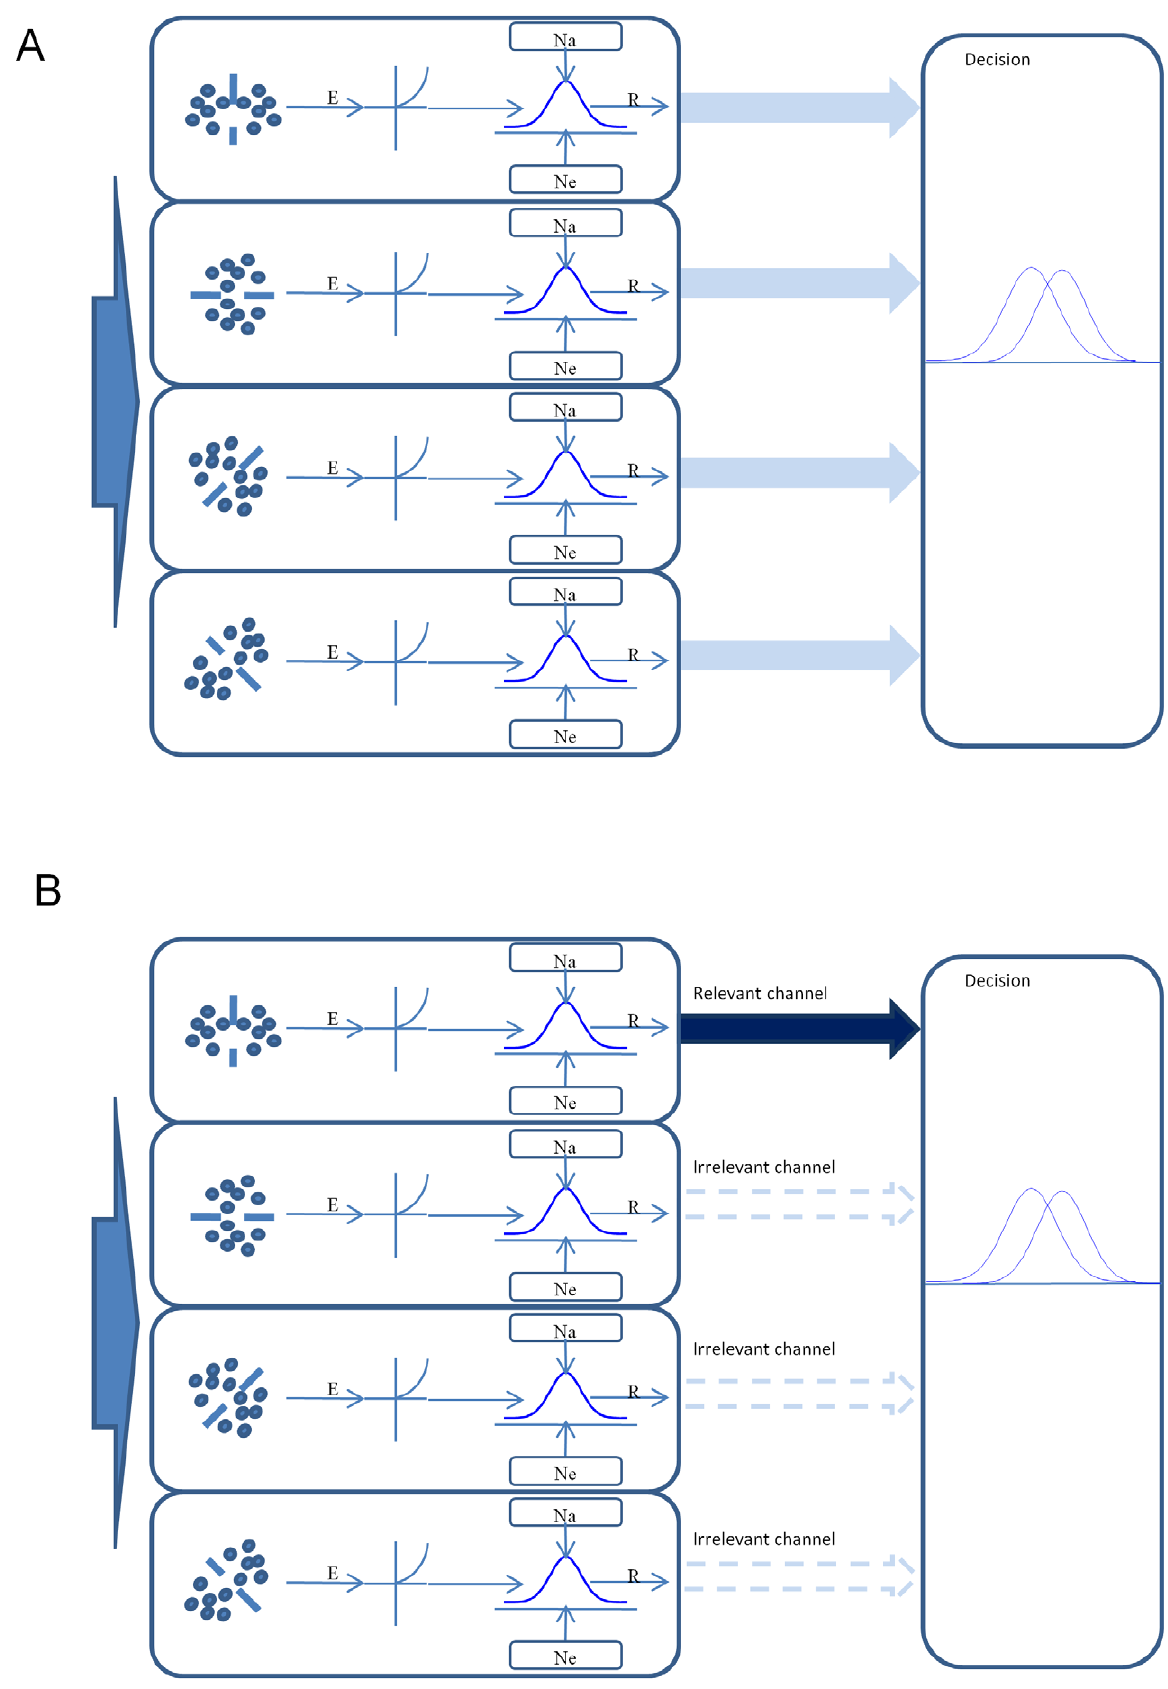
Figure 5. Diagram of the model. A. Without cues. B. With cues. See text for details. doi:10.1371/journal.pone.0009840.g005 PLoS ONE |